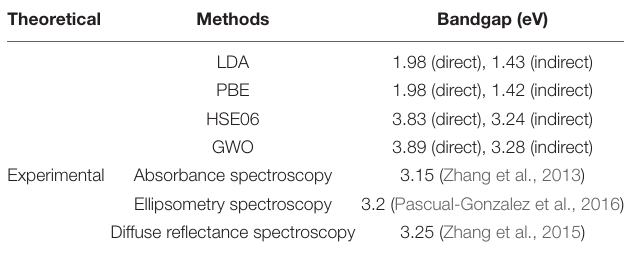
Frontiers in Materials |